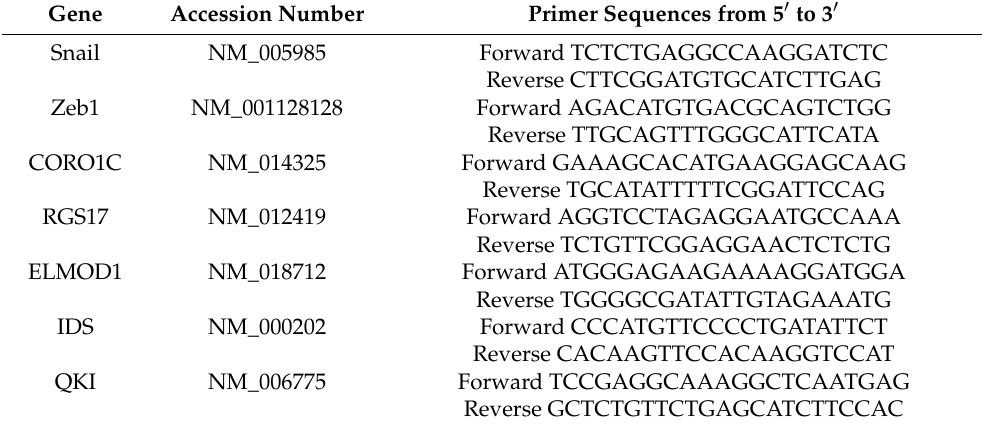
Table 1. qPCR primer